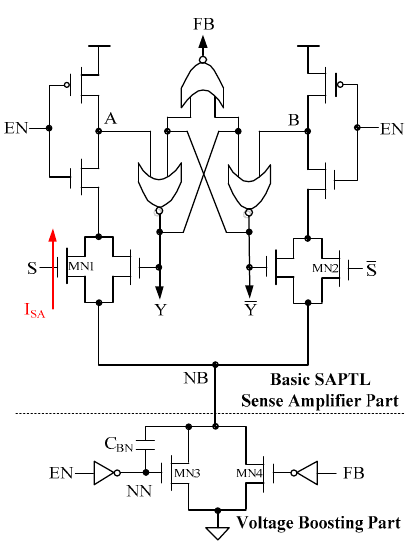
Figure 1. The structure of the bootstrapped sense amplifier.